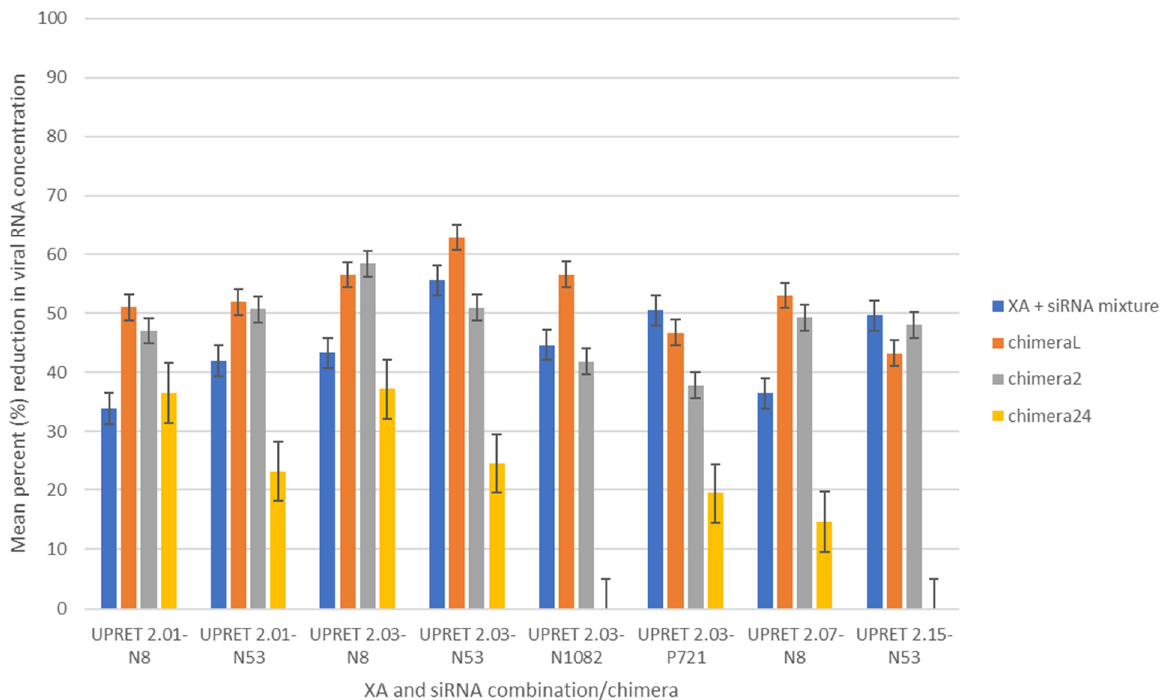
Figure 3. Mean percent reduction (Y-axis) comparison of the XA + siRNA mixture and each of the variations of the chimera (X-aptamer–avidin–siRNA) experiments (ChimeraL, low concentration; Chimera2, working concentration; and Chimera24, working concentration with treatment 24 h after challenge) targeting RABV CVS-11-infected cells. The working concentrations for Chimera2 and Chimera24 were 30 nM XA and 10 μ M siRNA. All treatments were tested at 2 h post infection, except for Chimera24 that was tested at 24 h post infection. All the experiments were undertaken in sextuplicate. The mean of the results from the Chimera24 trials was statistically significantly different compared to those of all the other trials ( p < 0.01). There was no significant difference between any of the other trials.